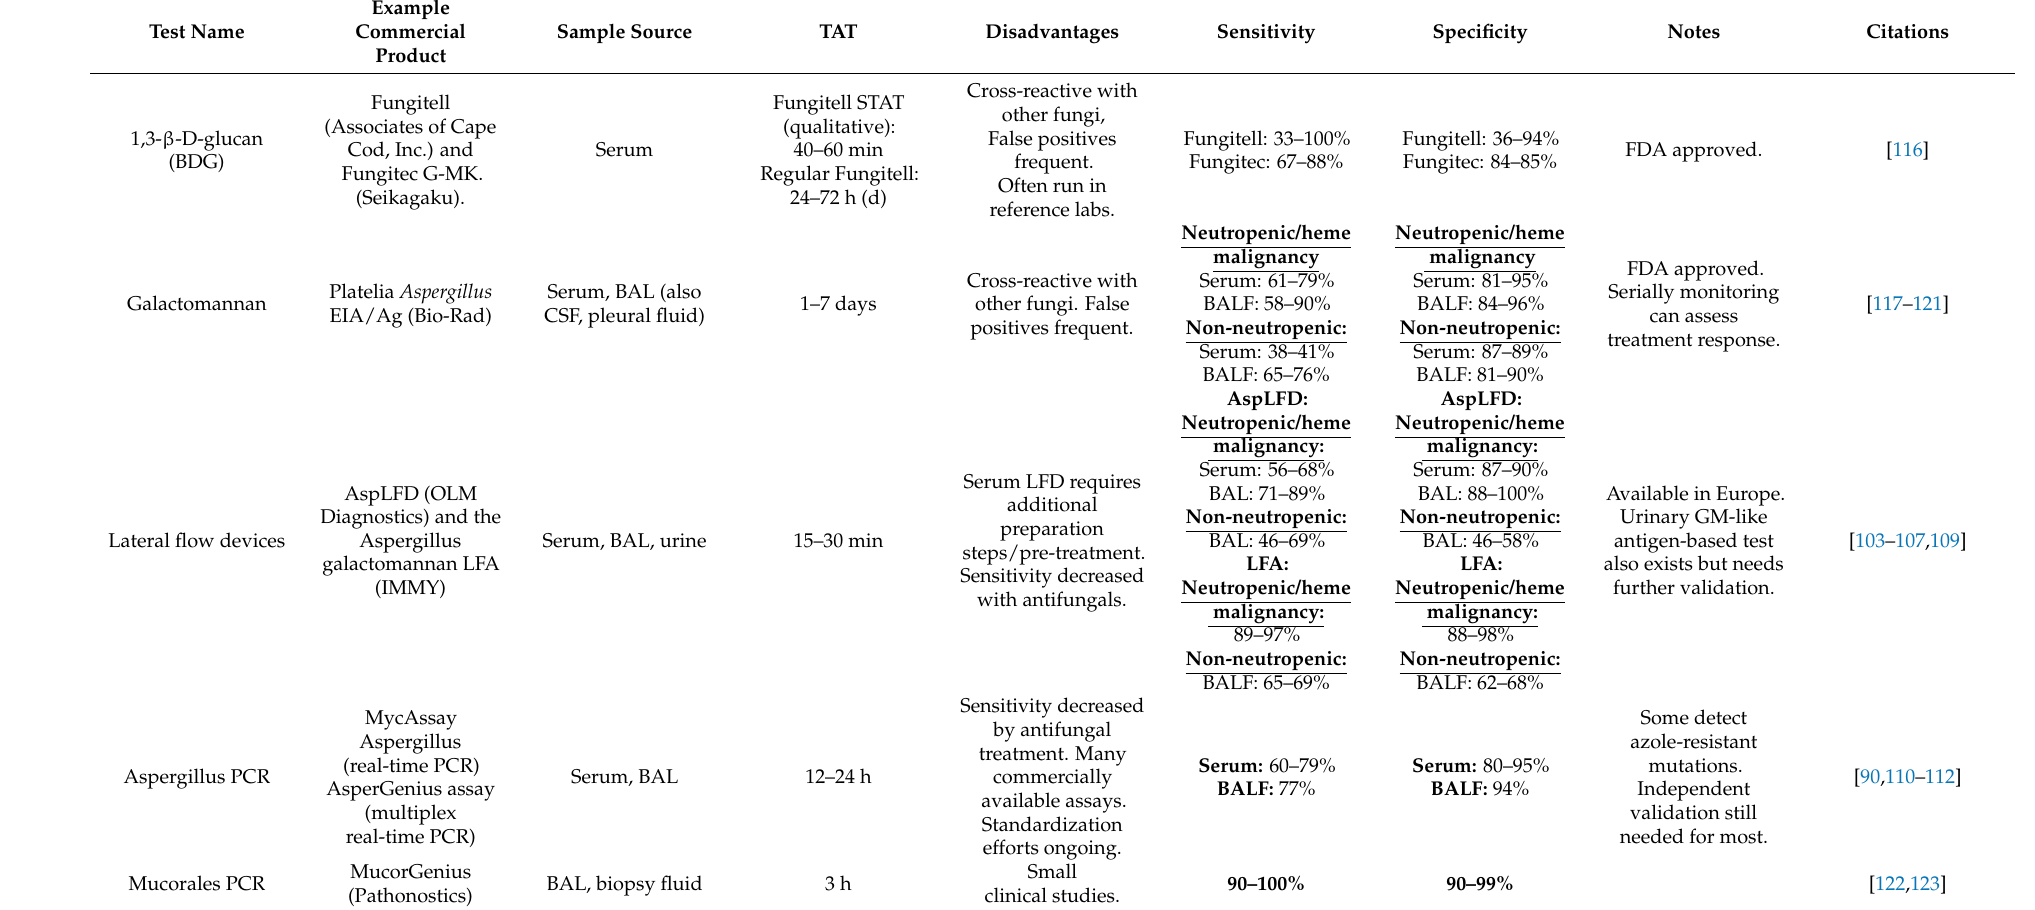
Table 2. Commercially available non-culture-based testing for Aspergillosis and